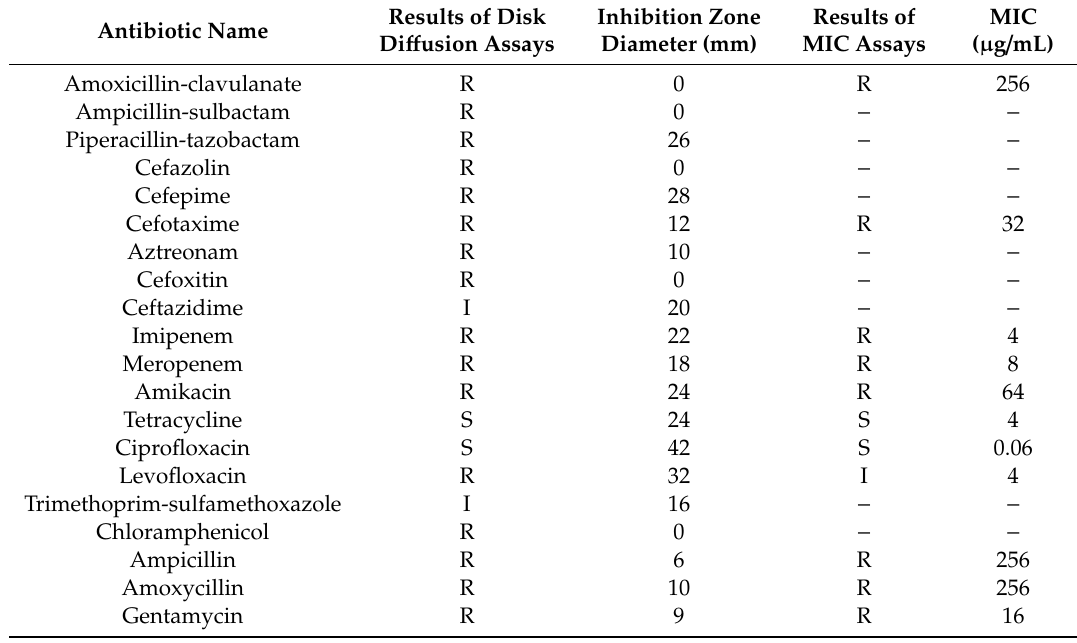
Table 1. Antibiotic susceptibility analysis performed while using the disk di ff usion method and the determination of minimum inhibitory concentrations